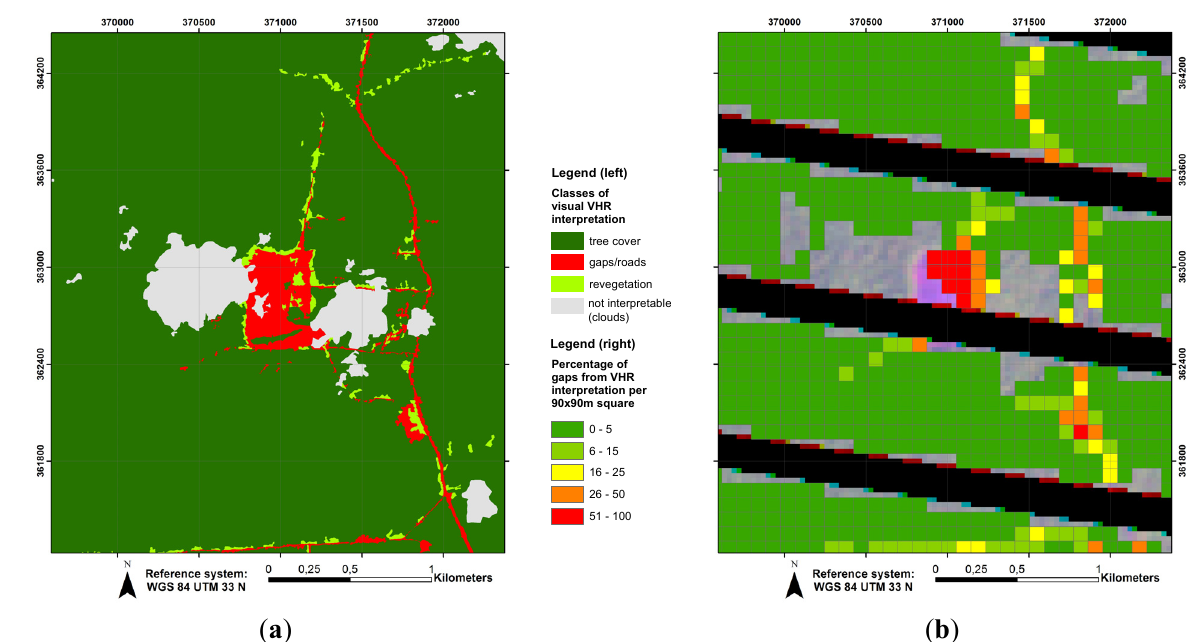
Figure 3. ( a ) Visual interpretation result; ( b ) 90 × 90 m aggregated visual interpretation result (percentage of gaps for interpretable areas) superimposed on Landsat SLC-off image (bands